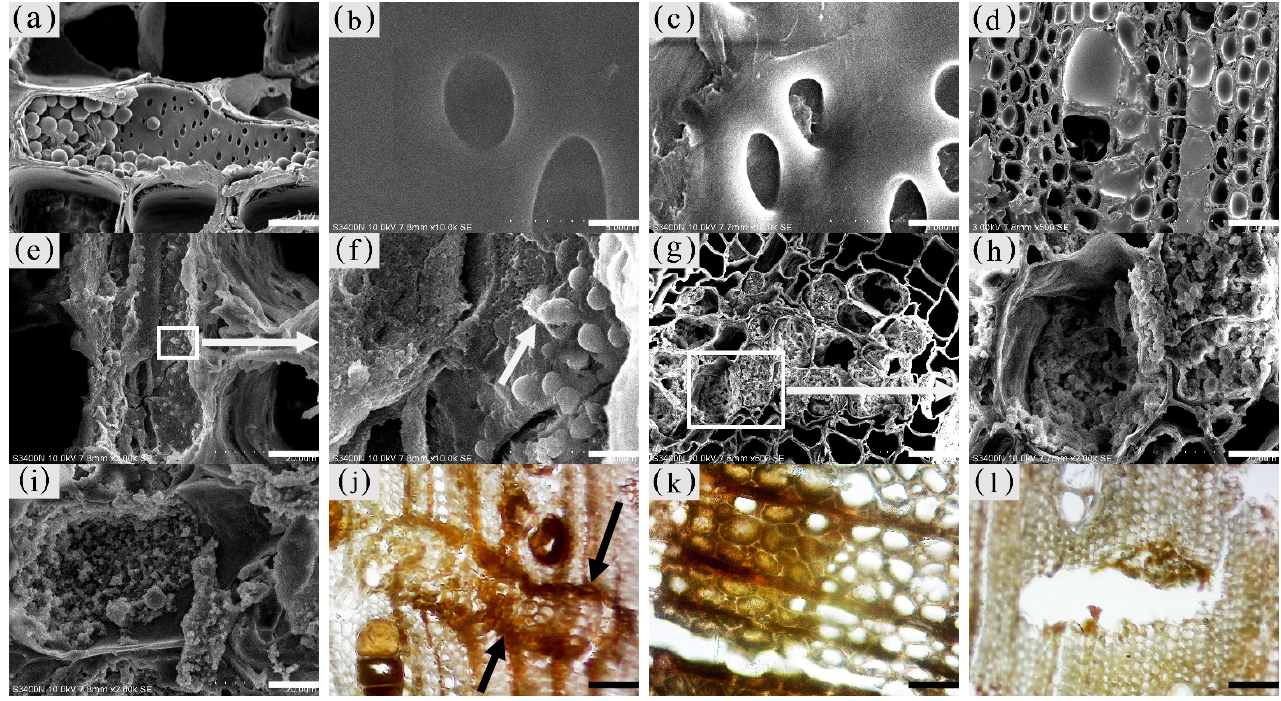
Figure 12. Accumulation of inclusions in parenchyma cells of xylem of A. sinensis . ( a ) Radial surface of white zone, with starch grains in wood rays and no inclusions. ( b ) Grain of xylem rays in white zone, with no inclusions. ( c ) Grain of xylem rays in transition zone, with inclusions. ( d ) Transverse surface of transition zone, with the resin in the xylem rays and vessels. ( e , f ) Xylem rays of transition zone, ( f ) is a partial enlargement of ( e ), and the arrow in ( e ) shows the invaginations. ( g ) Interxylary phloem of transverse surface in the agarwood zone, with large amounts of inclusions. ( h , i ) Transverse surface of agarwood zone, ( g ) is a partial enlargement of ( h ). ( i ) Transverse surface of decay zone, with large amounts of inclusions in the xylem rays. ( j ) Interxylary phloem of transverse surface in the agarwood zone: arrow is darker here than in other areas. ( k ) Fibers containing inclusions in the transverse surface of the agarwood zone. ( l ) Partially decayed interxylary phloem in the transverse surface of the decay zone. Scale bars= ( a ) 15 µ m; ( b , c , f ) 2 µ m; ( d ) 40 µ m; ( e , h , i ) 10 µ m; ( g ) 35 µ m; ( j , l ) 200 µ m; ( k ) 50 µ